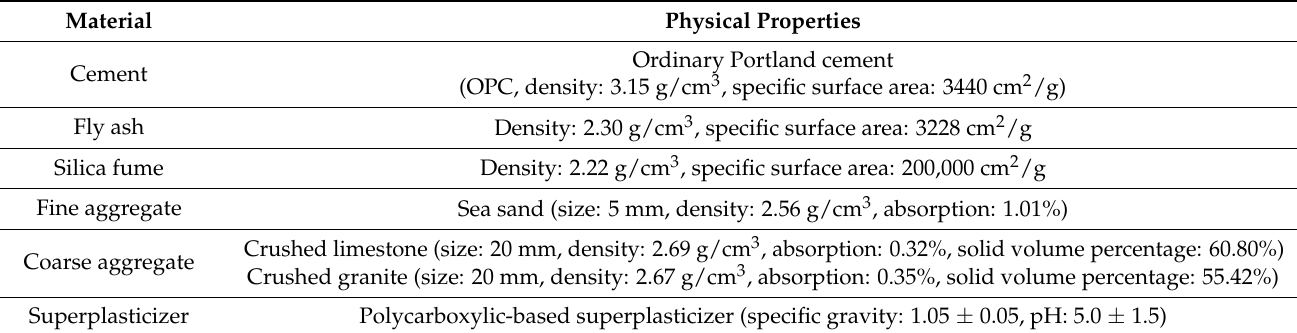
Table 3. Physical–mechanical properties of used material.